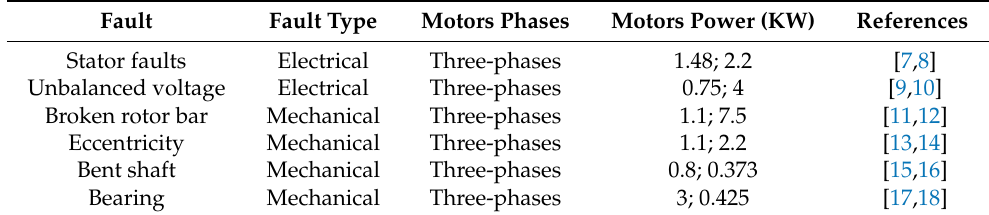
Table 1. Common IM defects and work